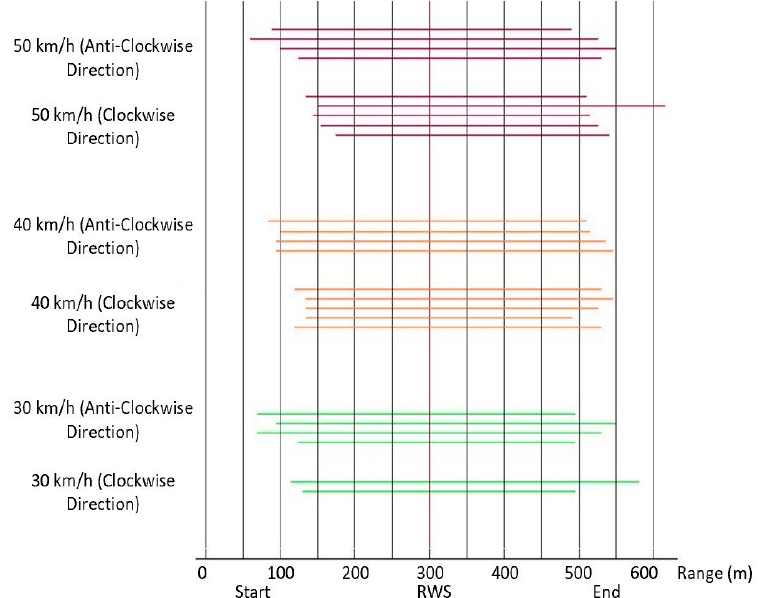
Figure 6. RWS communication range (m) on a test-track in Vehicle-to-Infrastructure communication (V2I) using heterogeneous networking.